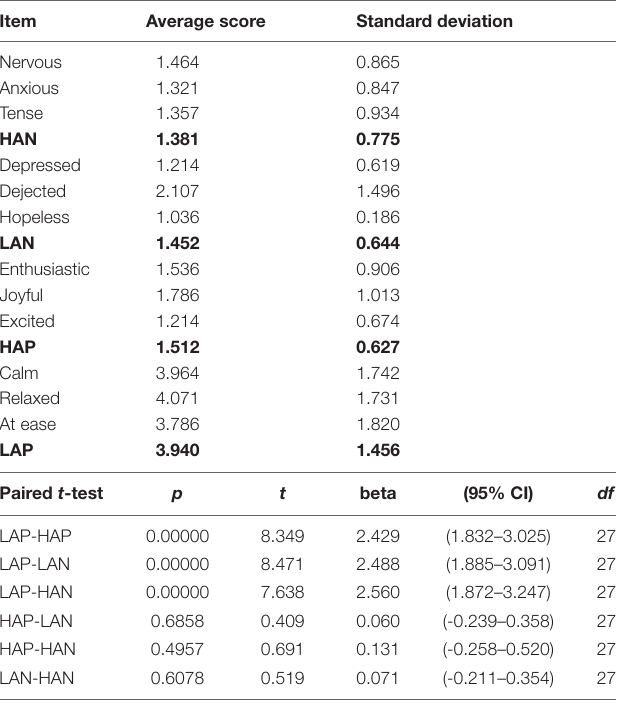
We report t-test results for comparing affective states during ASMR. HAN, High- activation negative state; LAN, Low-activation negative state; HAP, High-activation positive state; LAP, Low-activation positive state; df, Degrees of freedom.